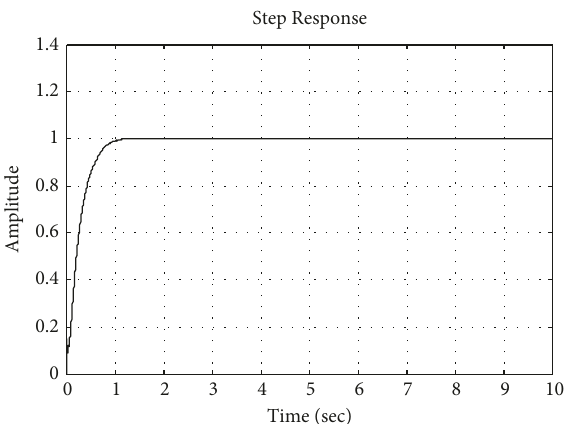
Figure 35: Self-antidisturbance control step response curve of control